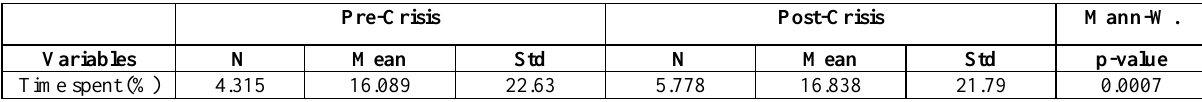
Table 1. Senior Management's Time Spent on Dealing with Regulations